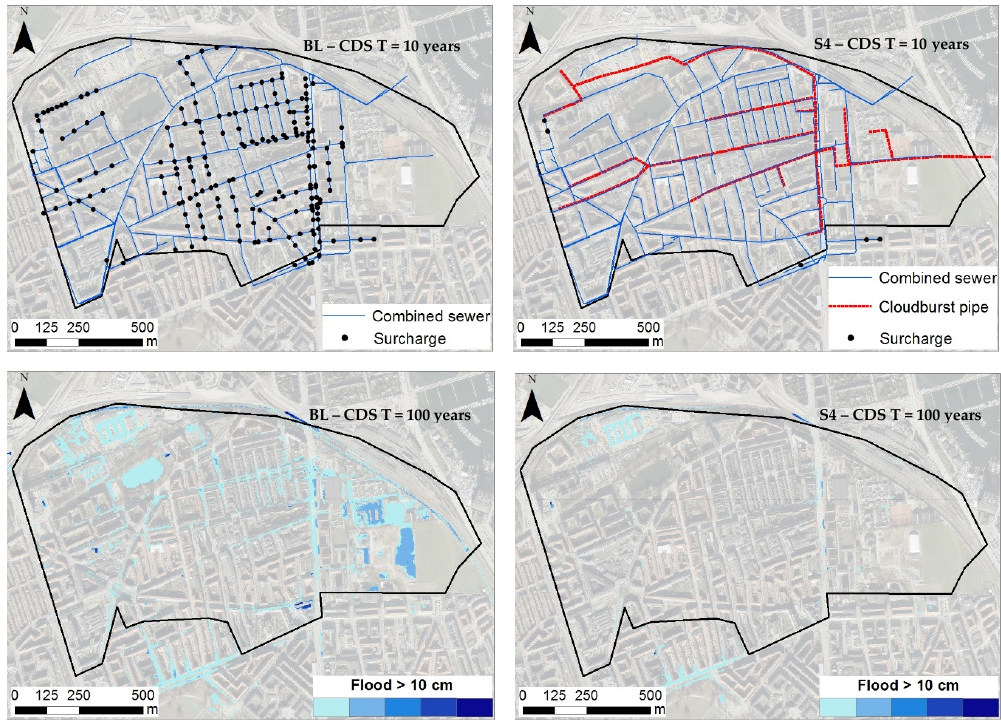
Figure 5. Extent of manhole surcharge under a 10-years Chicago Design Storm (CDS) ( upper panels ) and maximum flood levels above 10 cm under a 100-years CDS ( lower panels ) for the baseline scenario (BL, left side ) and for the last design scenario (S4, right side ).